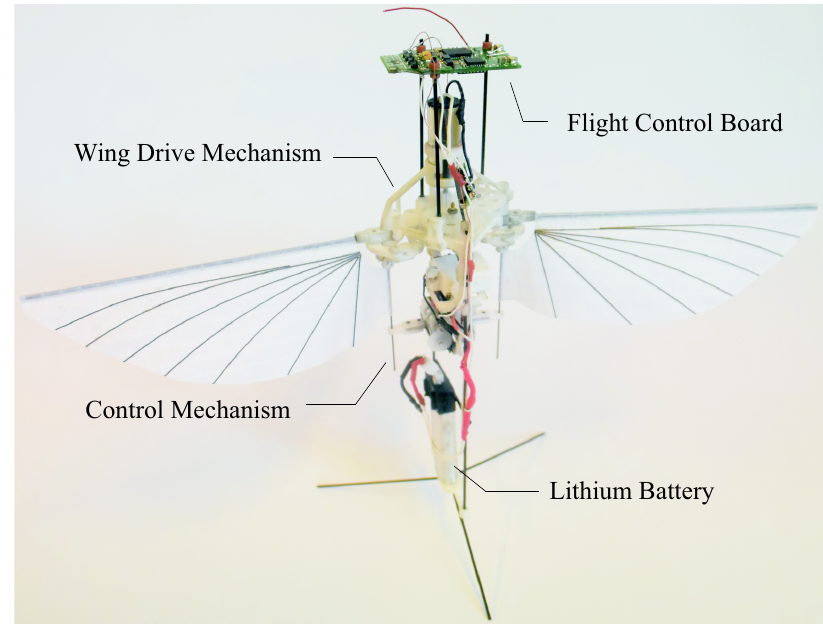
Figure 1. The COLIBRI